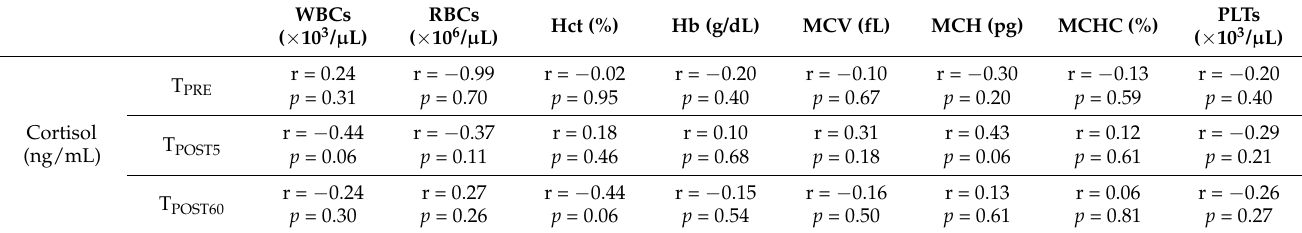
Figure 1. Representative cellulose acetate electrophoretograms of serum proteins were obtained from ewes before shearing (T PRE ) and after 5 (T POST5 ) and 60 (T POST60 ) min from the end of the shearing procedure. Table 3. Coefficients of correlation (Pearson’s r and p -value) among the serum concentration of cortisol, the levels of white blood cells (WBCs), red blood cells (RBCs), hematocrit (Hct), hemoglobin (Hb), mean corpuscular volume (MCV), mean corpuscular hemoglobin (MCH), mean corpuscular hemoglobin concentration (MCHC) and platelets (PLTs) measured in ewes before shearing (T PRE ) and after 5 and 60 min (T POST5 and T POST60 ) from the end of shearing. p -values < 0.05 were considered statistically